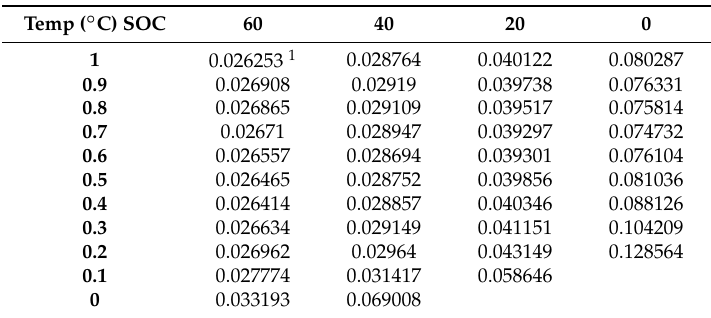
Table 1. Ohmic resistances by offline parameters